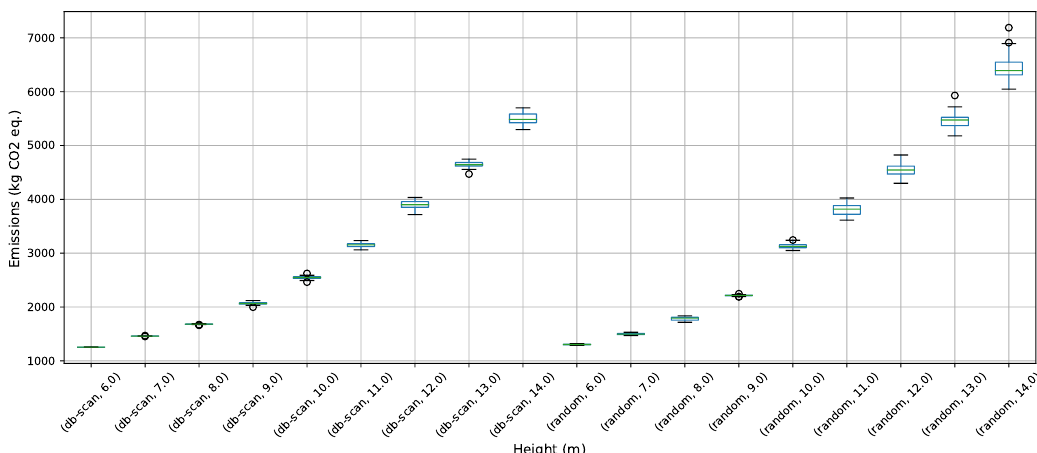
Figure 8. Emission box-plots, comparison between db-scan and random